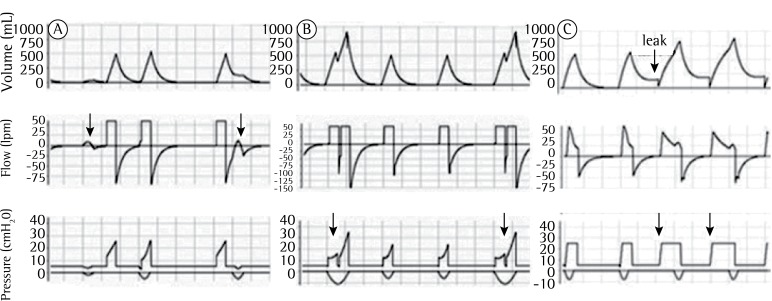
Trigger asynchronies identified in volume-, flow- and pressure-time
curves, indicated by arrows. Negative deflections in the pressure-time
curves represent the patient's inspiratory effort (muscle pressure), which
are only visible when the esophageal pressure is monitored. Panel A) Lost
efforts. The first arrow indicates a weak stimulus, which is unable to
trigger the ventilator, thus resulting in a small positive flow wave and
minimal tidal volume. The second arrow points to effort during expiration,
which failed to trigger the ventilator and merely sufficed for the flow to
return to baseline and become slightly positive. Panel B) Double-triggering.
Example in volume-controlled ventilation. The patient's inspiratory efforts
persist at the time of cycling-off, thus triggering another cycle. The
corresponding volumes are added together (stacking), and the airway pressure
increases, causing the high-pressure alarm to go off. Panel C)
Auto-triggering. In the support pressure mode, some cycles are triggered
without a patient inspiratory effort, which can be facilitated by leaks;
this is observed in the volume-time curve, which does not return to baseline
(the inspired volume is greater than the expired volume). Figures obtained
at Xlung.net, a virtual mechanical ventilation simulator. Available at:
http//:www.xlung.net.